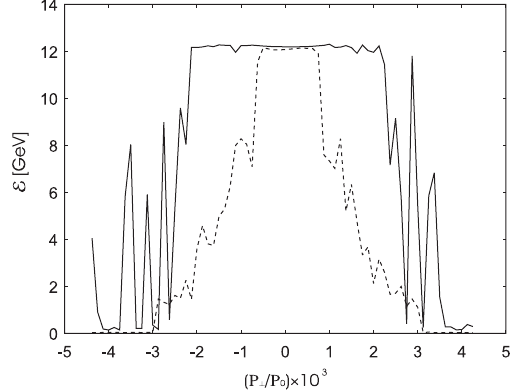
FIG. 7. The self-consistent law l ð x Þ of the undulator step change corresponding to maximal acceleration.